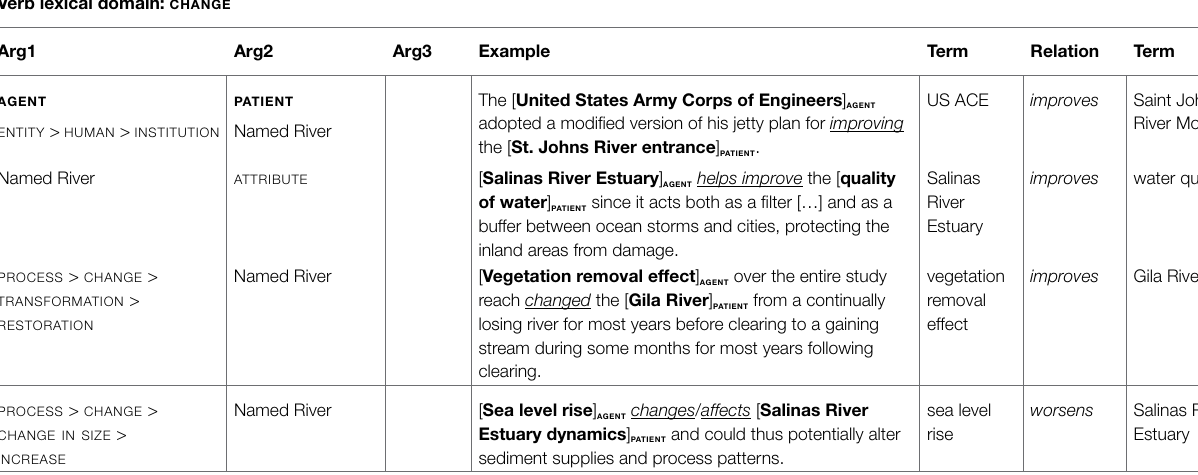
TABLE 6 | Results from the semantic annotations for the lexical domain of change . Verb lexical domain: